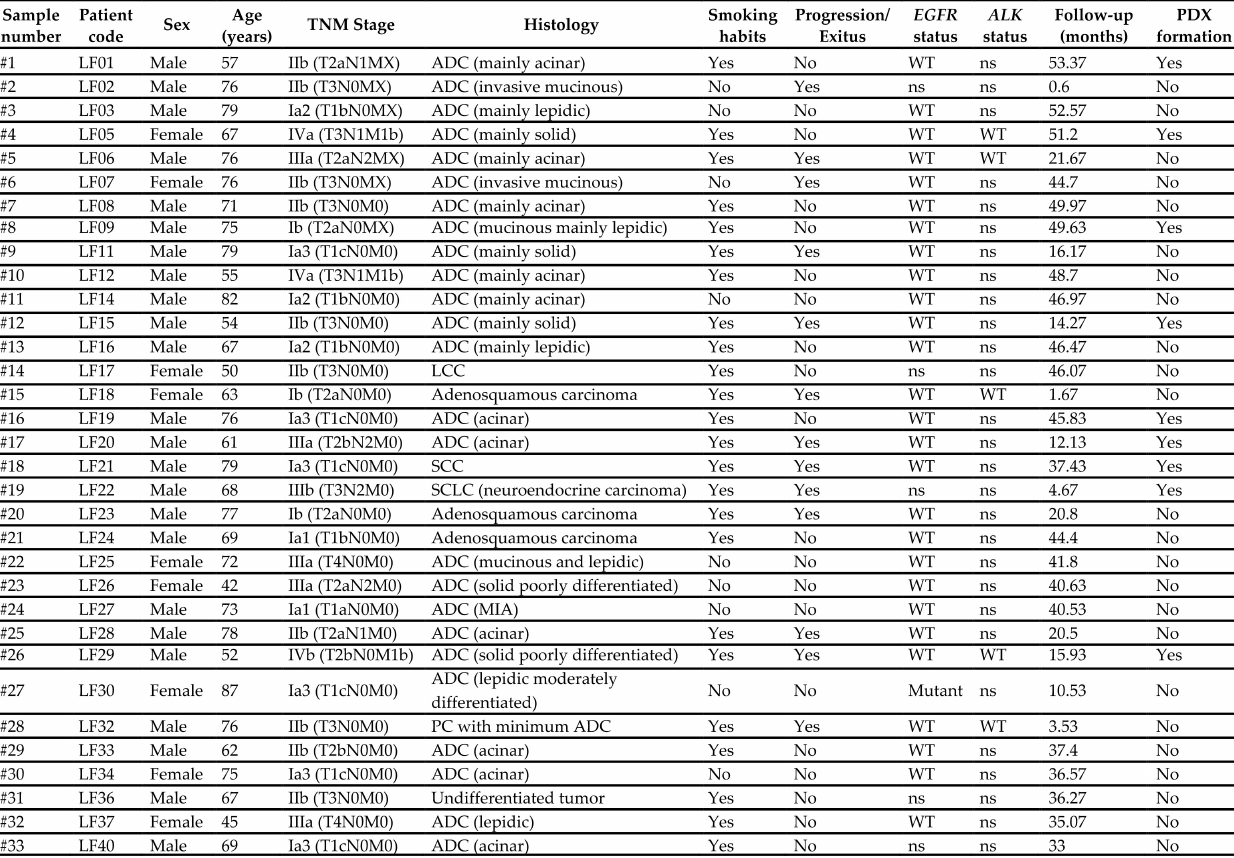
Table 1. Clinicopathological characteristics of the patients.